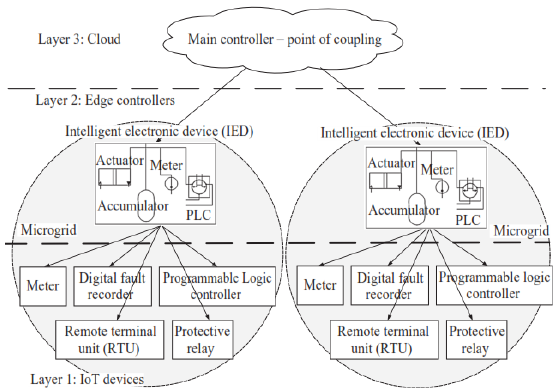
Figure 4 . Communication inside of micro-grid and its connection to the control layer.